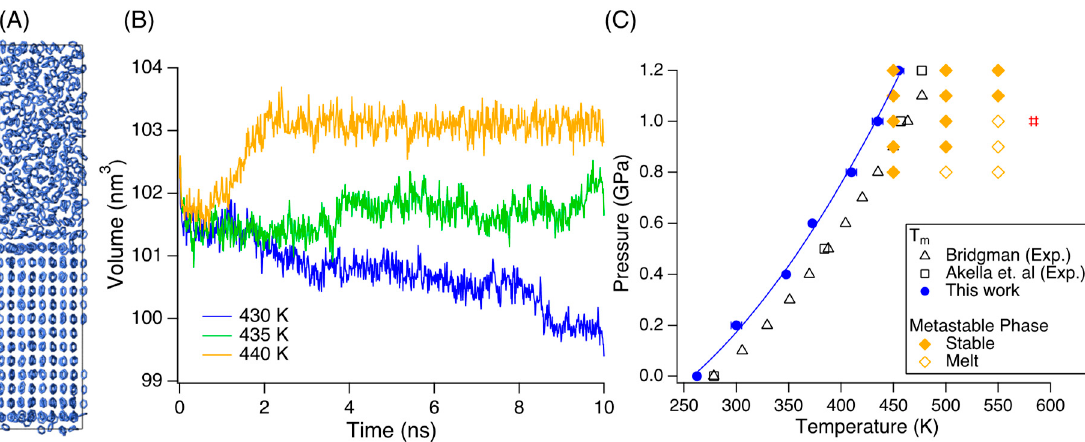
Figure 1. Two-phase method for T m : ( A ) initial configuration consisting of liquid and phase I structures, ( B ) time evolution of the total volumes in NpT MD simulations at 1.0 GPa and at three different temperatures (430, 435 and 440 K), ( C ) the resulting melting curve ( T m ) for the phase I (blue filled circles) with the experimental data by Bridgman (open triangles) [47] and by Akella et. al (open squares) [9]. The panel C also presents the homogeneous melting temperature (red sharp), and the stable (filled diamonds) and unstable (open diamonds) conditions for the metastable phase, estimated in this study.